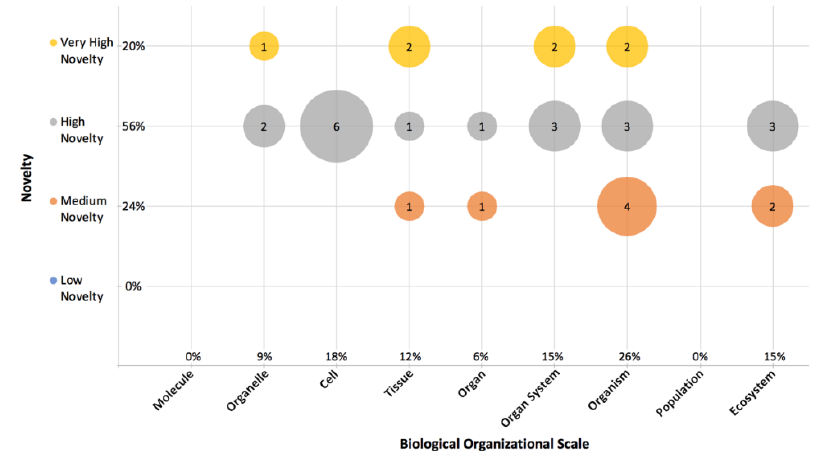
Figure 7. Novelty Distribution of Biomimetic Behaviors ( n = 34).